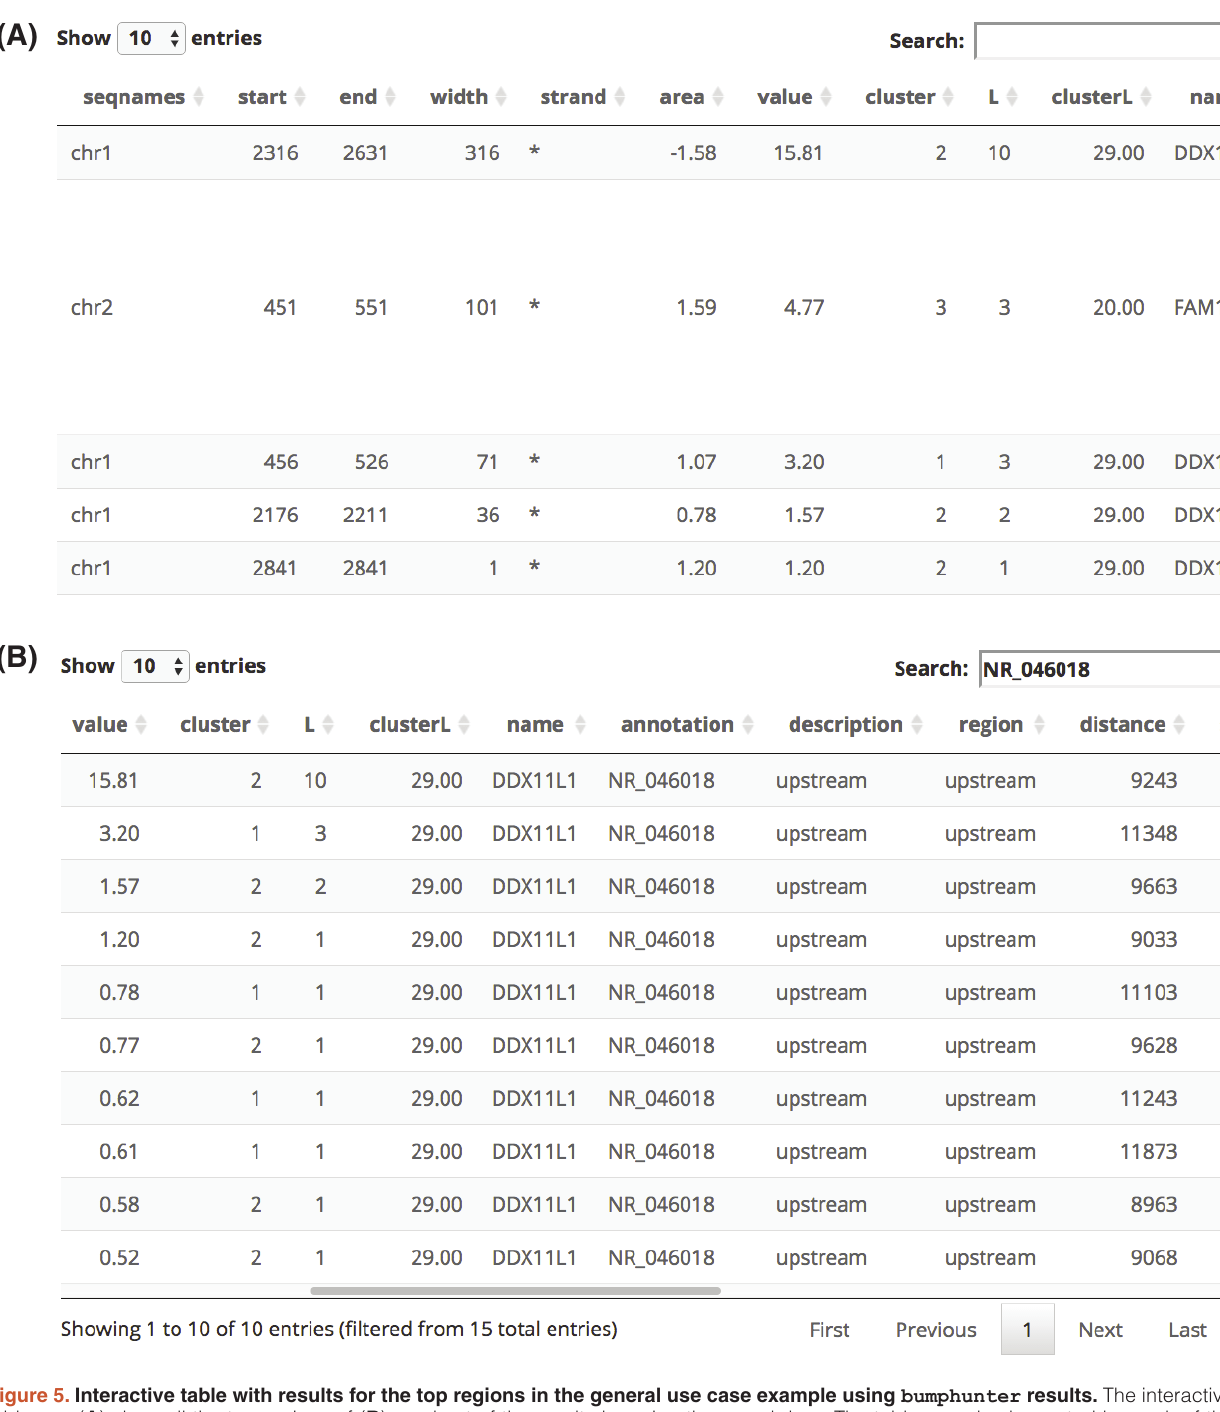
Figure 5. Interactive table with results for the top regions in the general use case example using bumphunter results. The interactive table can ( A ) show all the top regions of ( B ) a subset of the results by using the search box. The table can also be sorted by each of the different